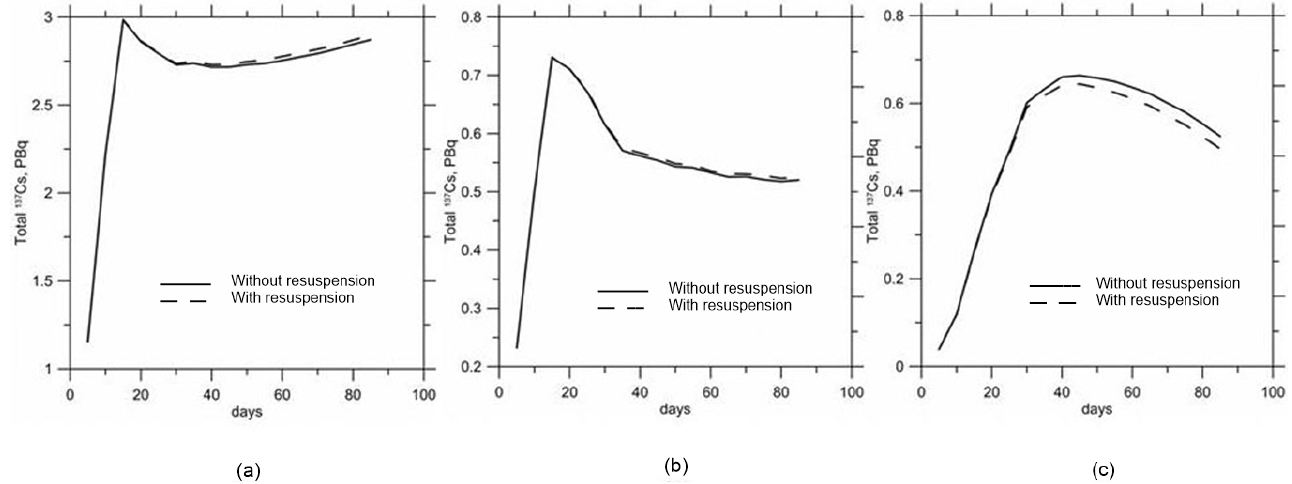
Figure 14. ( a ) Total amount of dissolved 137 Cs after release from the Hanbit NPP; ( b ) total amount of 137 Cs adsorbed on suspended sediments after release from the Hanbit NPP; ( c ) total amount of bottom contamination of 137 Cs after release from the Hanbit NPP.